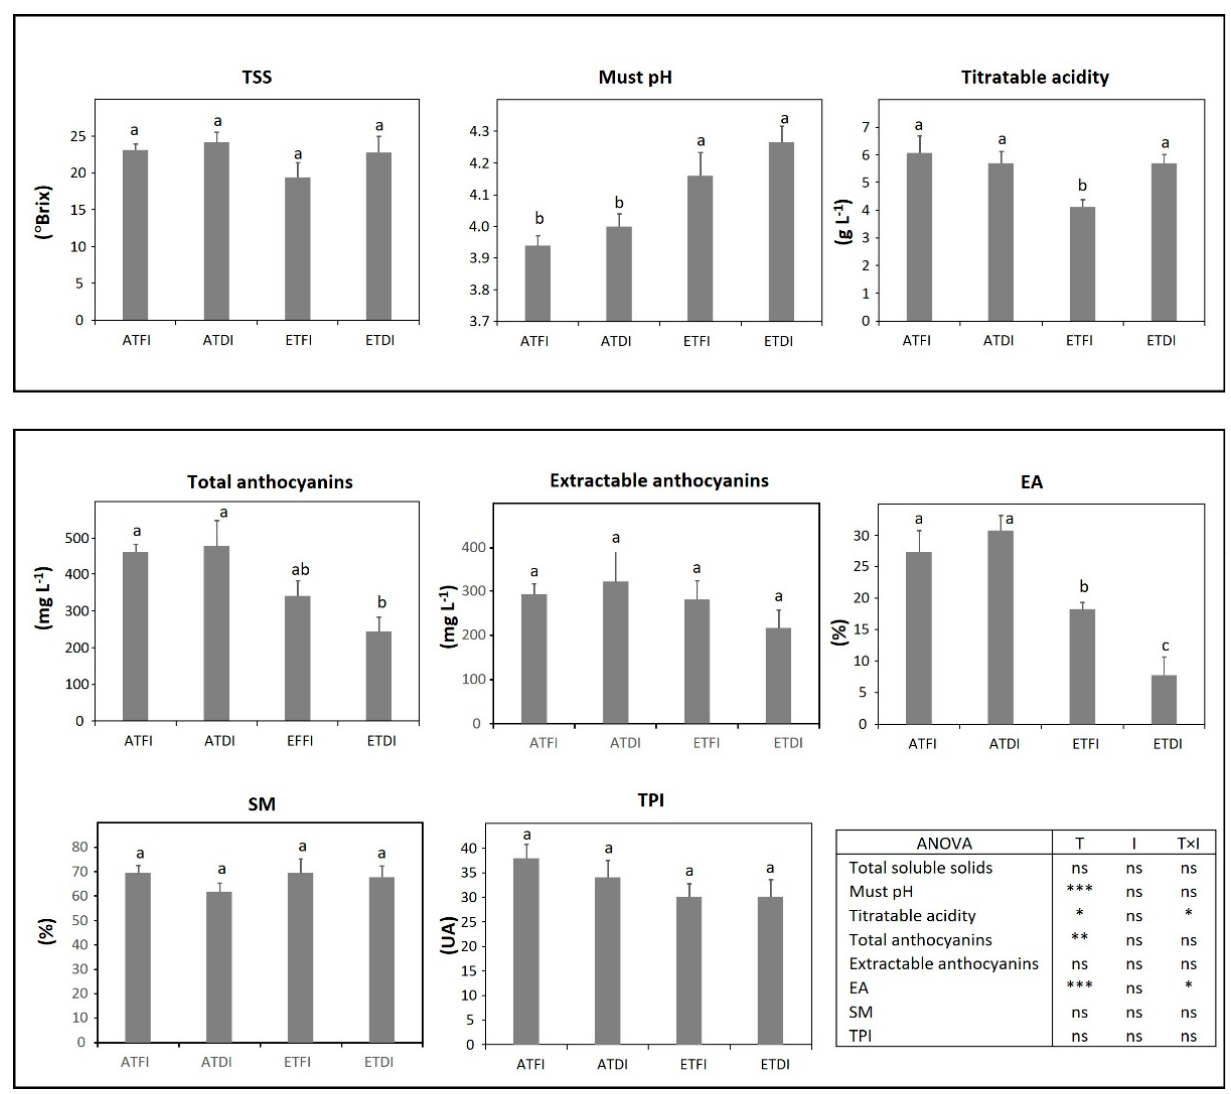
Figure 3. Grape technological and phenolic maturity assessed at harvest in fruit-bearing cuttings of Tempranillo (TEM) grown either at ambient (AT) or elevated temperature (ET) and subjected to different irrigation regimes (FI, full irrigation; DI, deficit irrigation). Values are means ± S.E. ( n = 5). Bars topped by the same letter do not differ significantly ( p > 0.05) according to Duncan’s test. Significance of the analysis of variance (ANOVA): * p < 0.05; ** p ≤ 0.01; *** p ≤ 0.001; ns, not significant ( p ≥ 0.05). TSS, total soluble solids; TPI, total polyphenol index; EA, cellular extractability of anthocyanins; SM, seed maturity; AU, absorbance units.